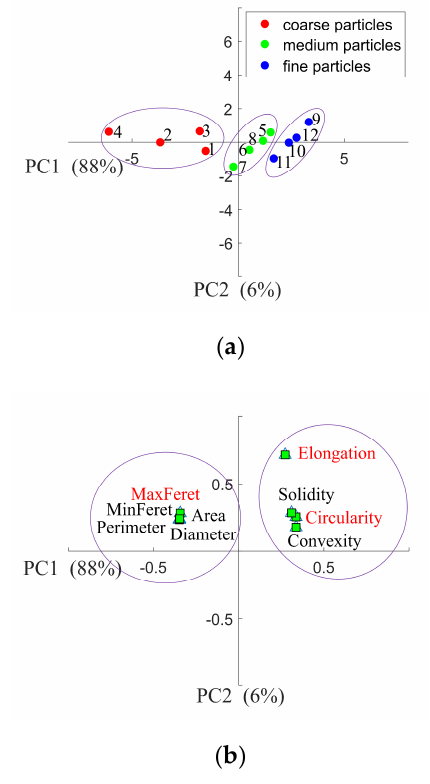
Figure 10. ( a ) Principal Component Analysis (PCA) scores plot of the first two principal components distinguishing the twelve instant whole milk powder samples from their bulk density; ( b ) PCA loadings plot of the first two principal components distinguishing the relationships between di ff erent shape